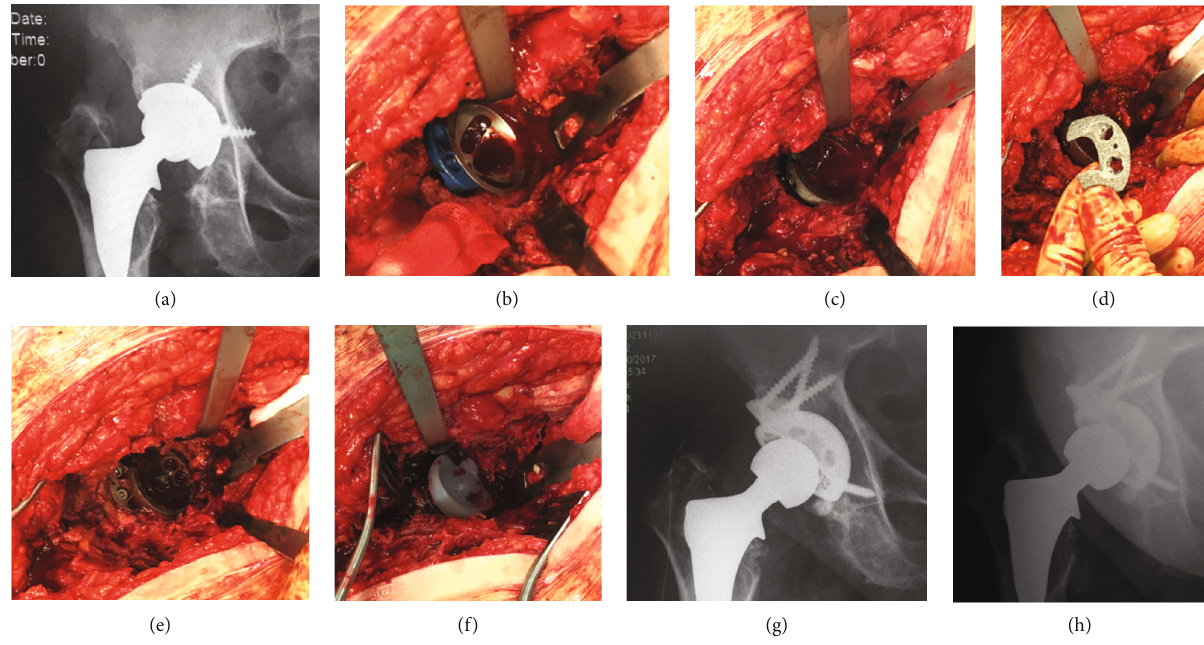
Figure 2: (a) Preoperative X-ray. (b) Simulation of reconstruction with trial implants. (c) Insertion of the cup. (d) “ Staple ” type implant. (e) Construct after augment implantation. (f) Polyethylene insertion. (g) Postoperative X-ray. (h) 5-year follow-up X-ray.